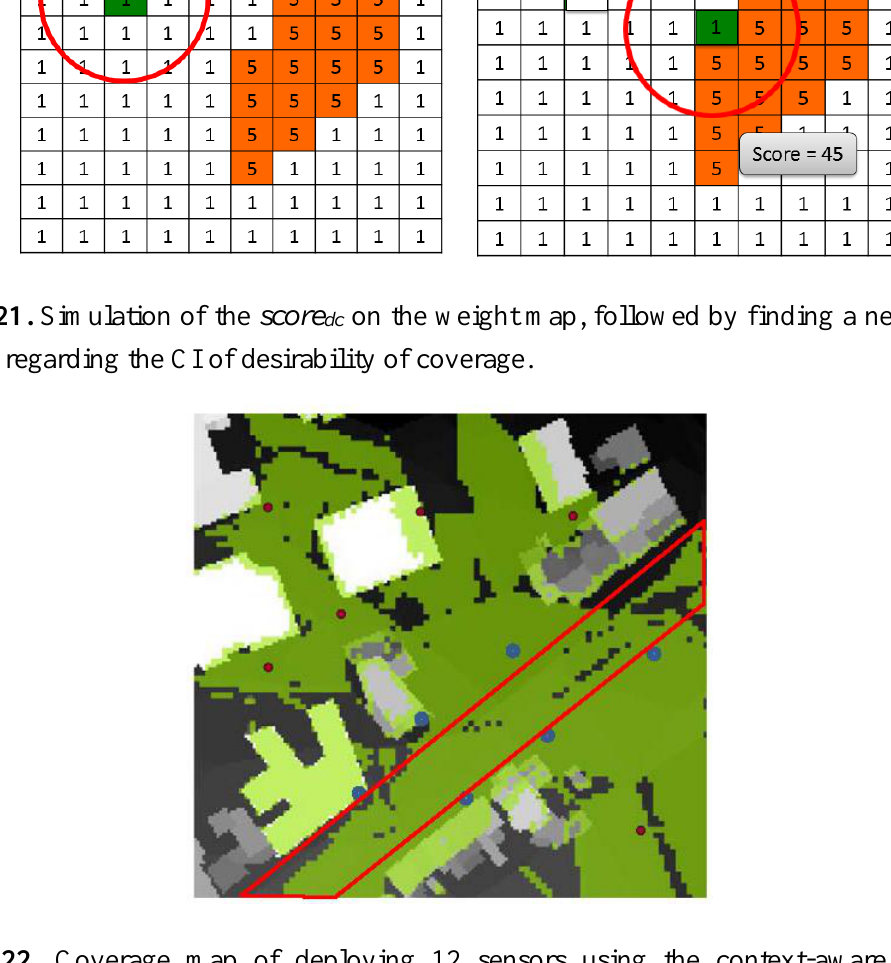
Figure 22. Coverage map of deploying 12 sensors using the context-aware method, considering the street (Zone 1) as the desired region to be covered (the red